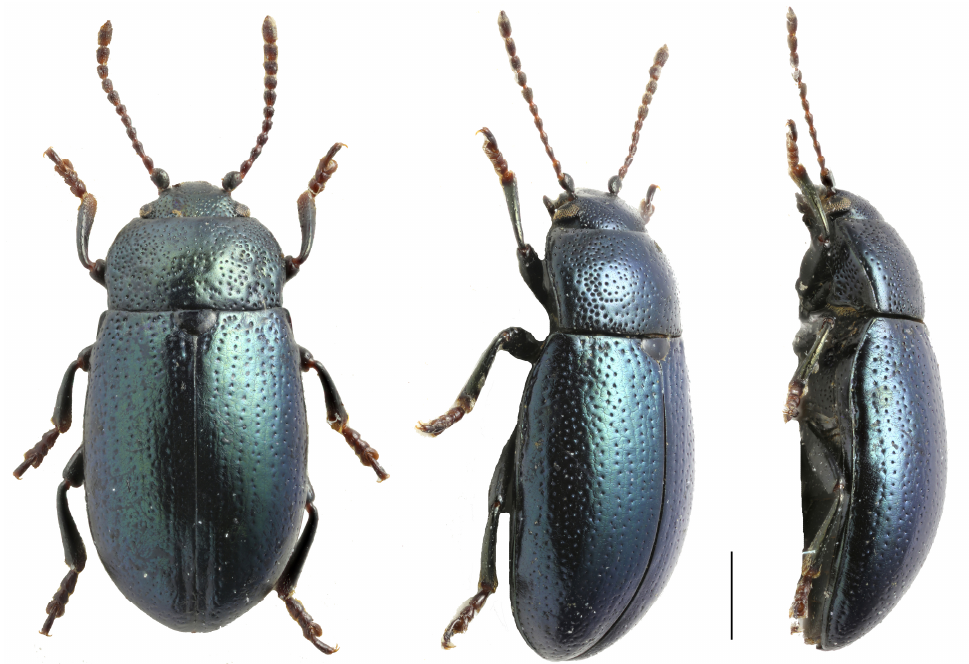
Figure 1. Apterocuris sibirica Jacobson, 1901, female (East Kazakhstan, Prokhodnoy Belok Mts.): habitus in dorsal, dorsolateral and lateral view. Scale bar—1 habitus in dorsal, dorsolateral and lateral view. Scale bar—1 mm.